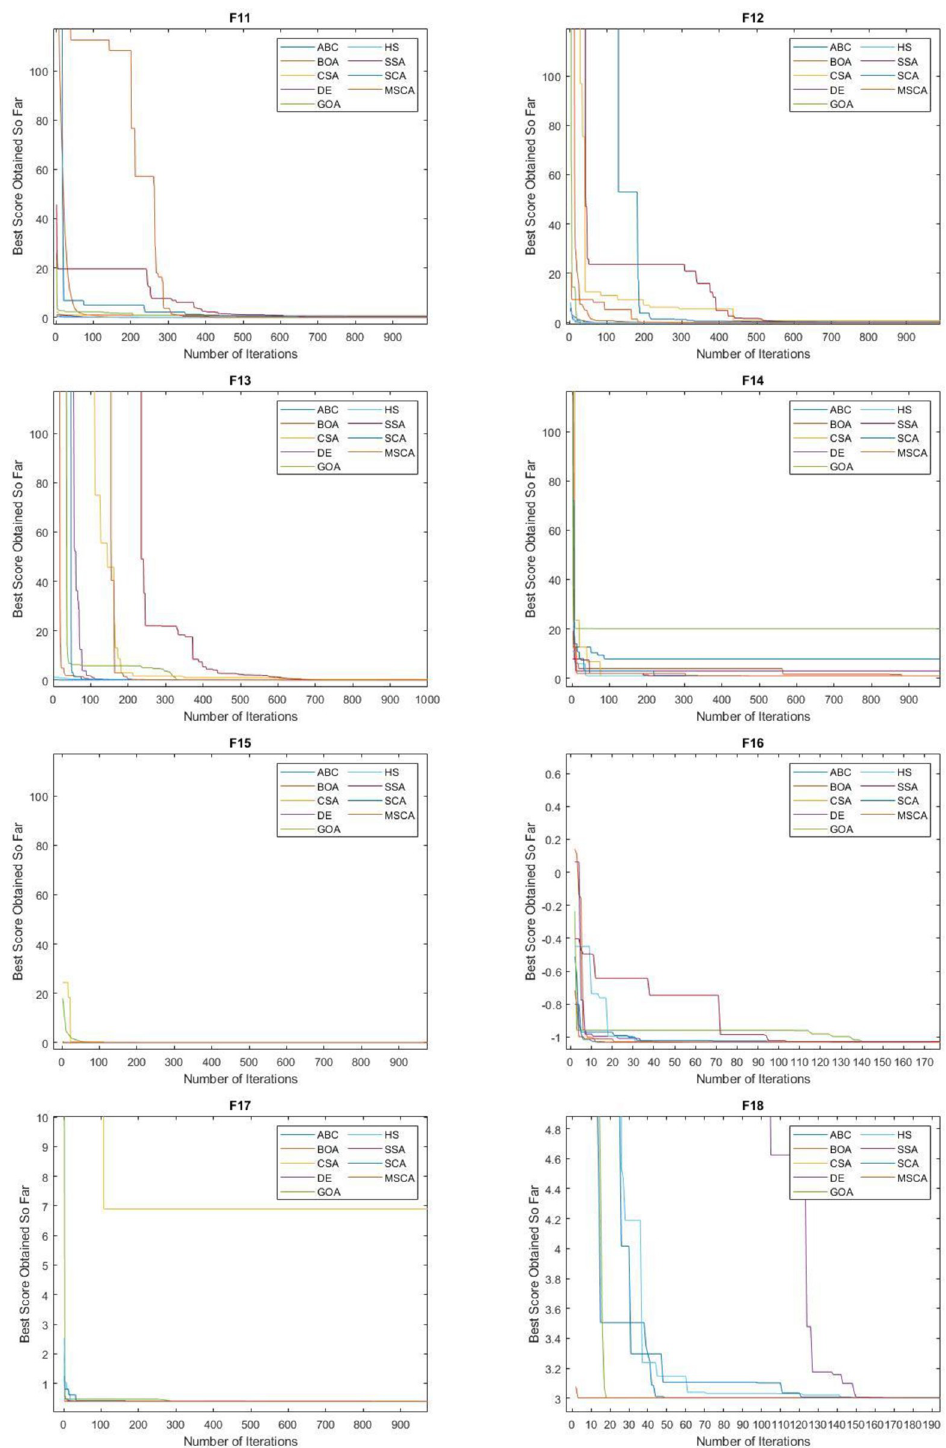
Fig 7. Convergence performance of MSCA algorithm on multimodal and composite functions.